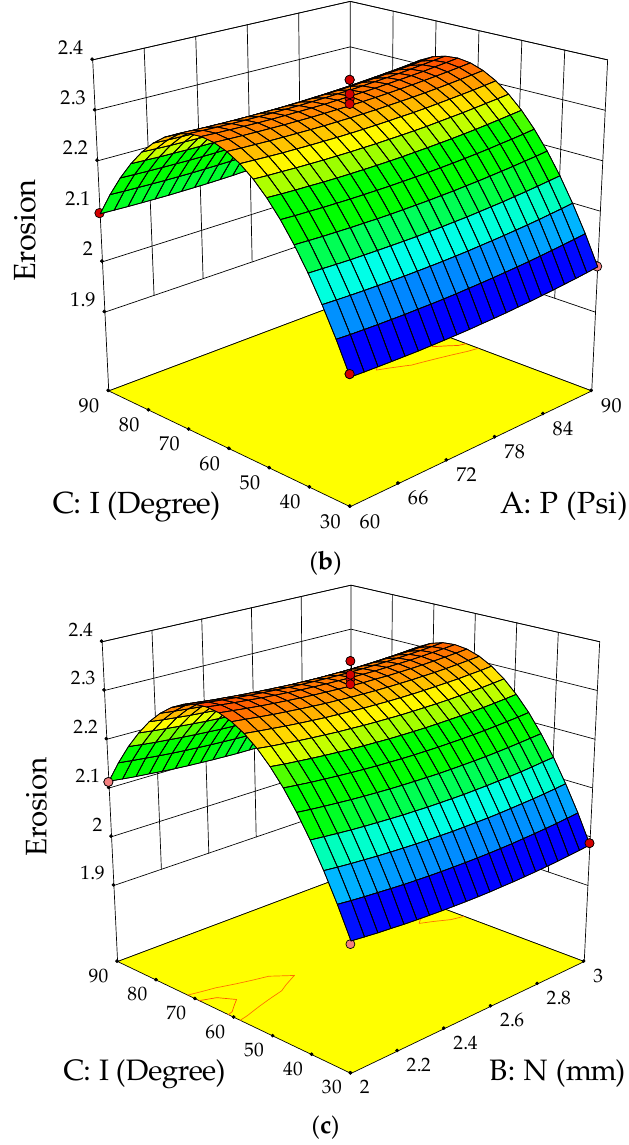
Figure 5. ( a ) Response surface plots for slurry pressure and nozzle diameter on erosion. ( b ) Response surface plots for slurry pressure and impingement angle on erosion. ( c ) Response surface plots for nozzle diameter and impingement angle on erosion.